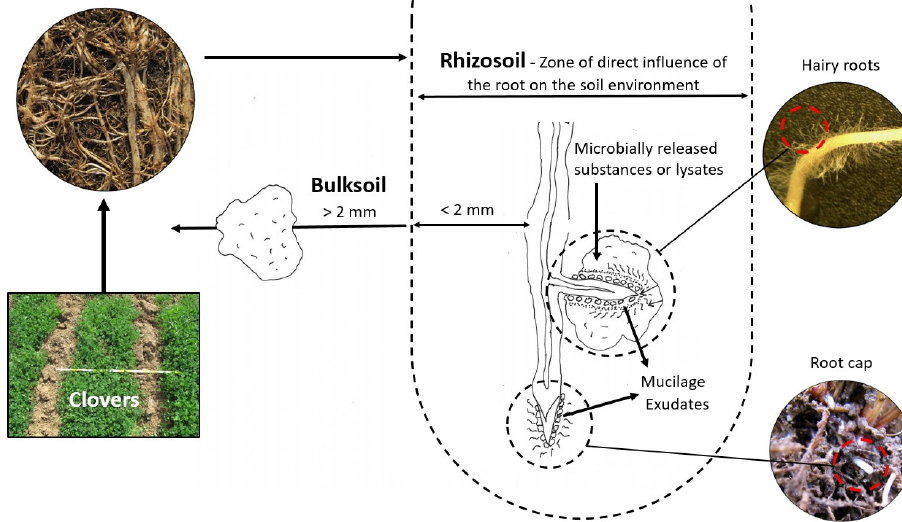
Figure 2. Pictorial representation of rhizosoil and bulk soil samplings. Table 2. Samples according to the species and root-soil proximity.